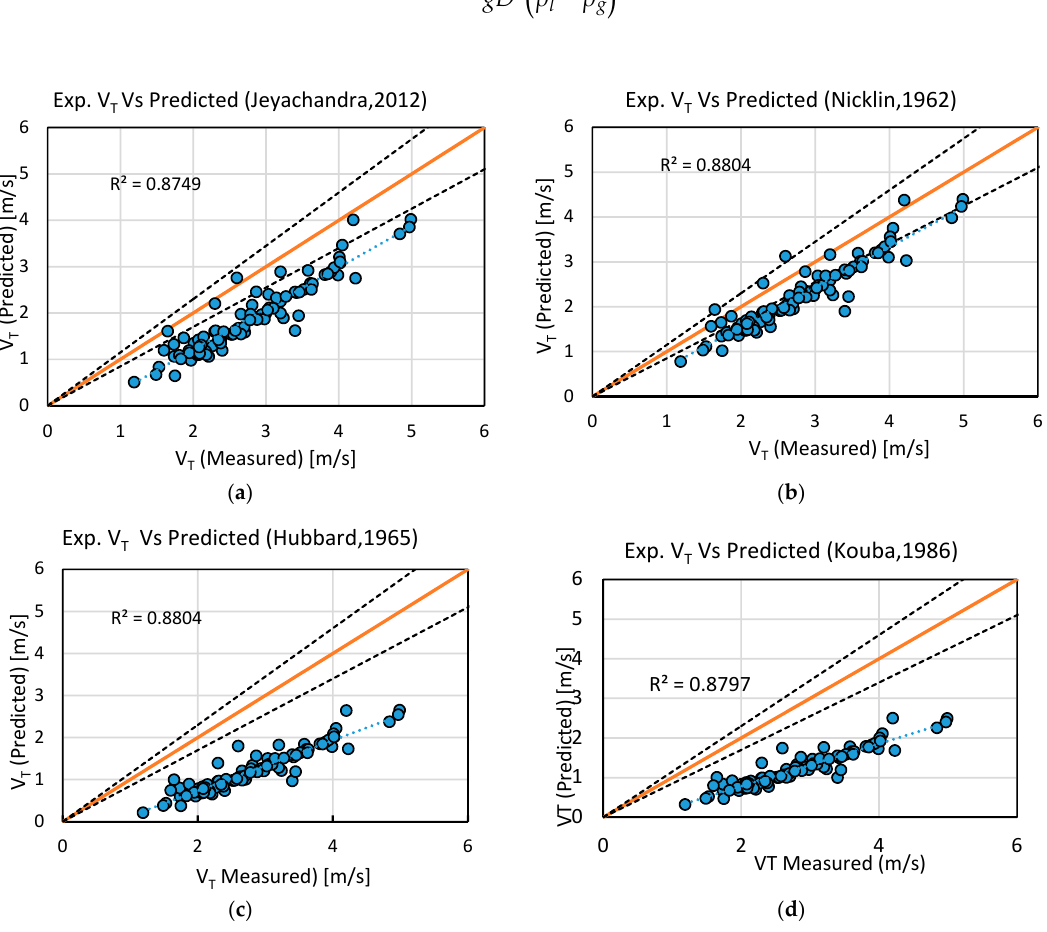
Figure 8. Comparison of the experimental data from the present study with several model predictions and experimental data for the present study. Model predictions are by ( a ) Jeyachandra et al. [24], ( b ) Nicklin [14], ( c ) Hubbard [44], and ( d ) Kouba [46]. The error bands represent a ± 15% deviation of the model from the present experimental slug translational velocities.